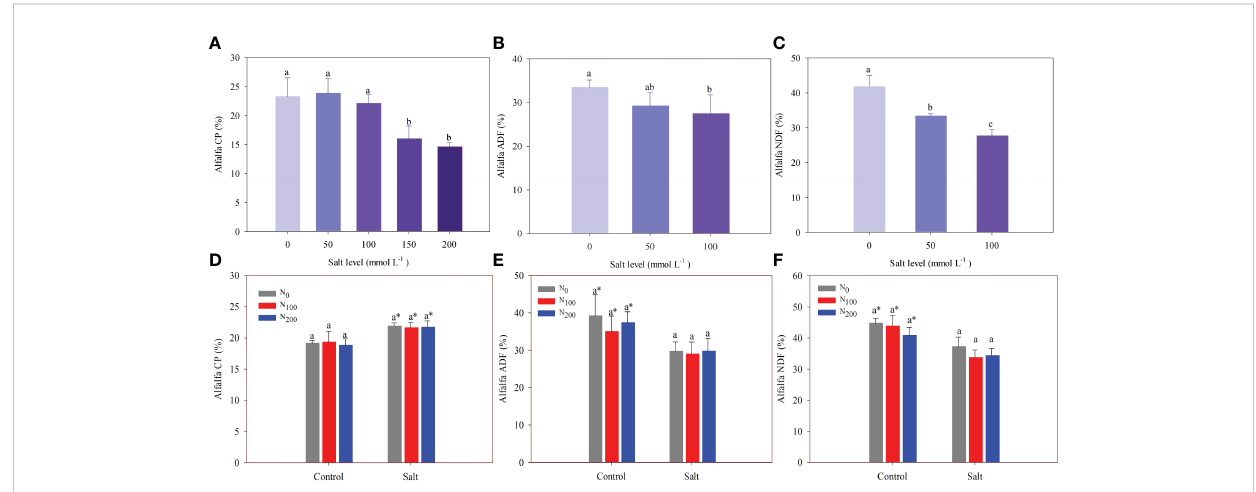
FIGURE 6 Alfalfa crude protein (CP) (A) , acid detergent fi ber (ADF) (B) , and neutral detergent fi ber (NDF) (C) in different salt levels in experiment 1. Incomplete ADF and NDF data owing to insuf fi cient sample weight (shoot dry weight). Alfalfa CP (D) , ADF (E) , and NDF (F) in different nitrogen (N) supply and salt levels in experiment 2. Error bars represent ± SD of the mean. Different letters represent a signi fi cant difference among treatments ( p ≤ 0.05). Asterisks refer to signi fi cant differences between salt levels at the same N fertilizer supply rates.